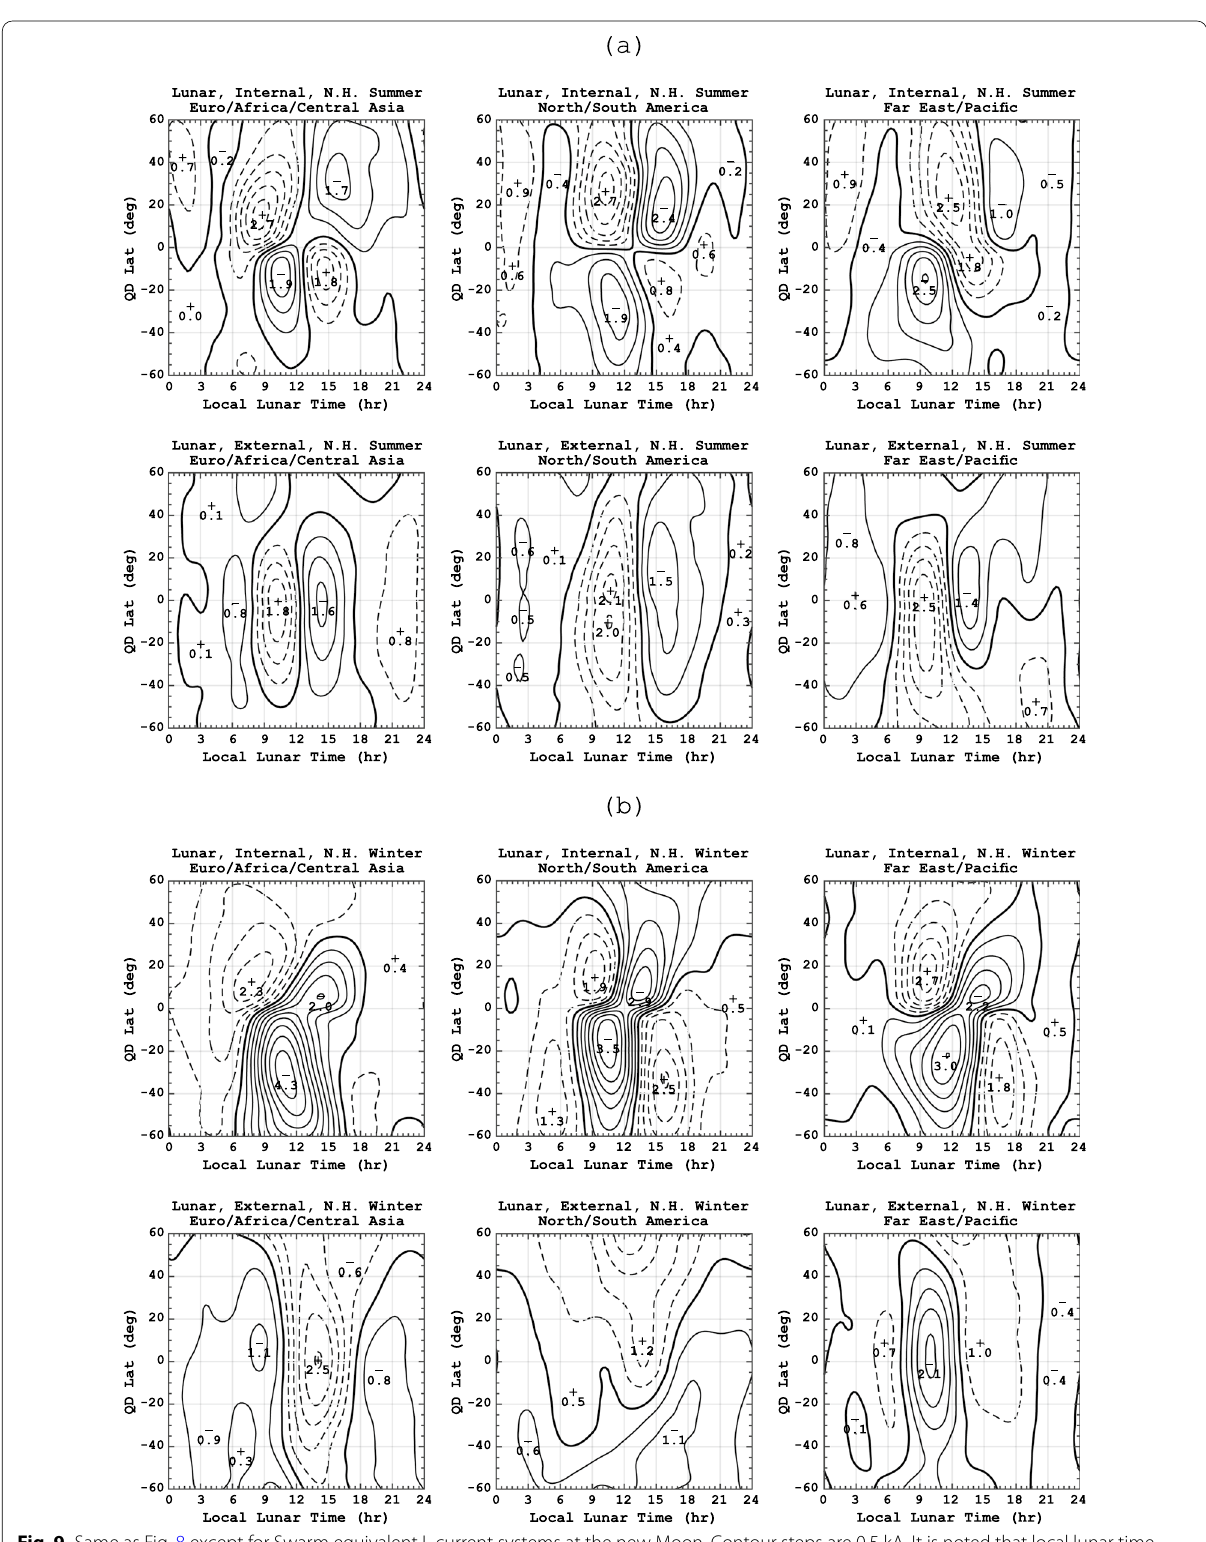
Fig. 9 Same as Fig. 8 except for Swarm equivalent L current systems at the new Moon. Contour steps are 0.5 kA. It is noted that local lunar time equals local solar time at the new